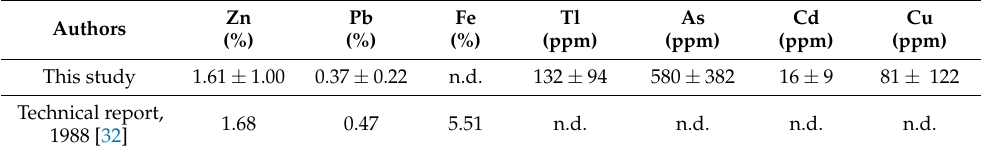
Table 1. Average ( ± standard deviation) flotation tailing chemical composition of the Raibl mine obtained in the present study and compared with previous results (n.d. not determined).